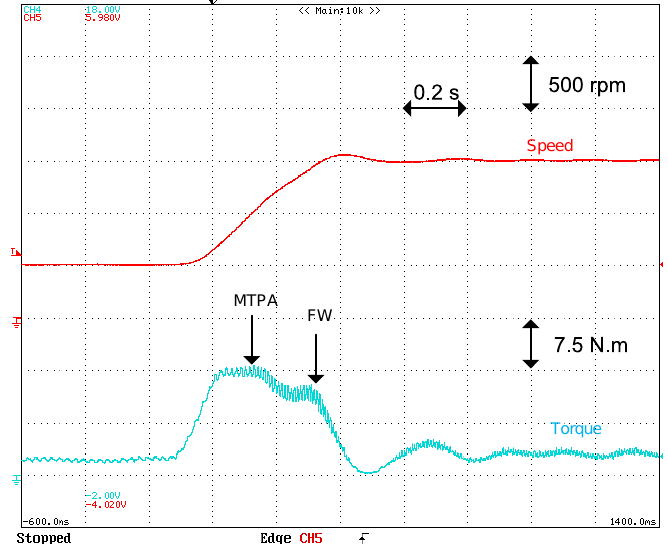
Figure 12. Dynamic responses of the GWO drive, incorporating control trajectories under constant torque